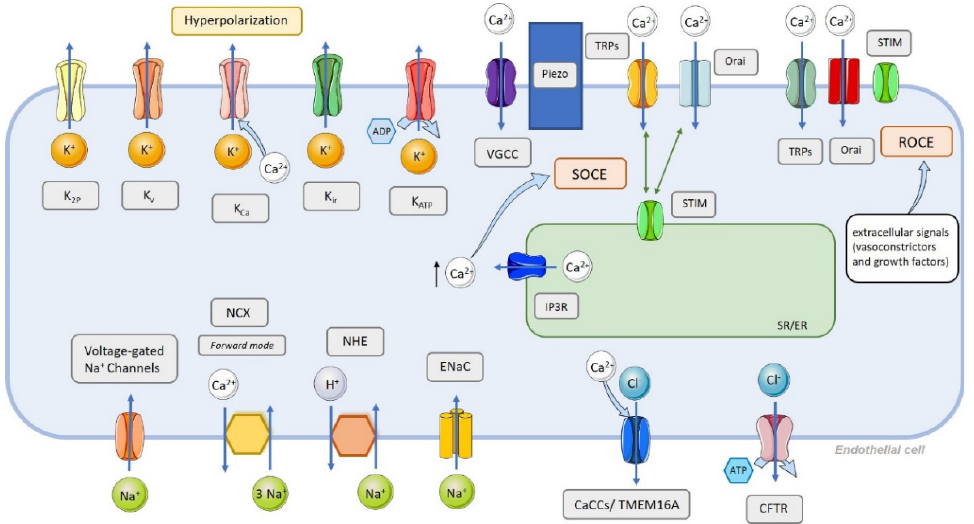
Figure 1. Overview of ion channels present in cells. ATP-sensitive K + channel (K ATP ); Ca 2+